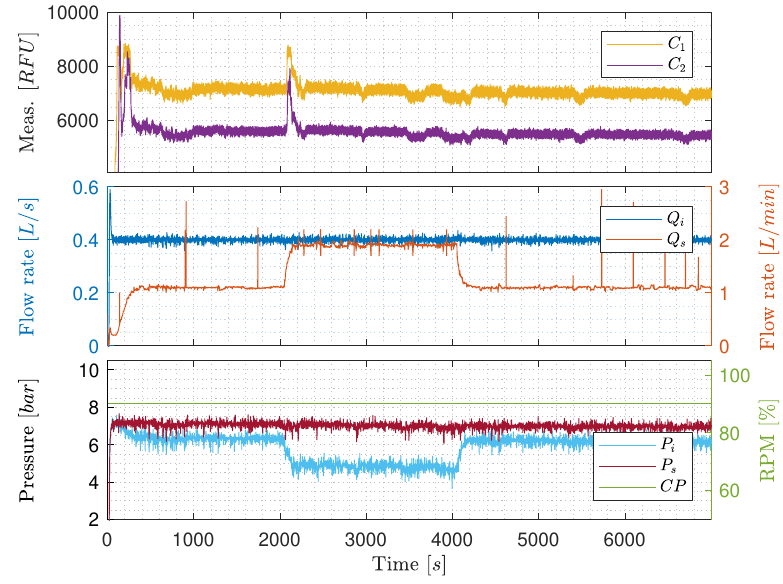
Figure 9. Constant pump speed with varying Q s .